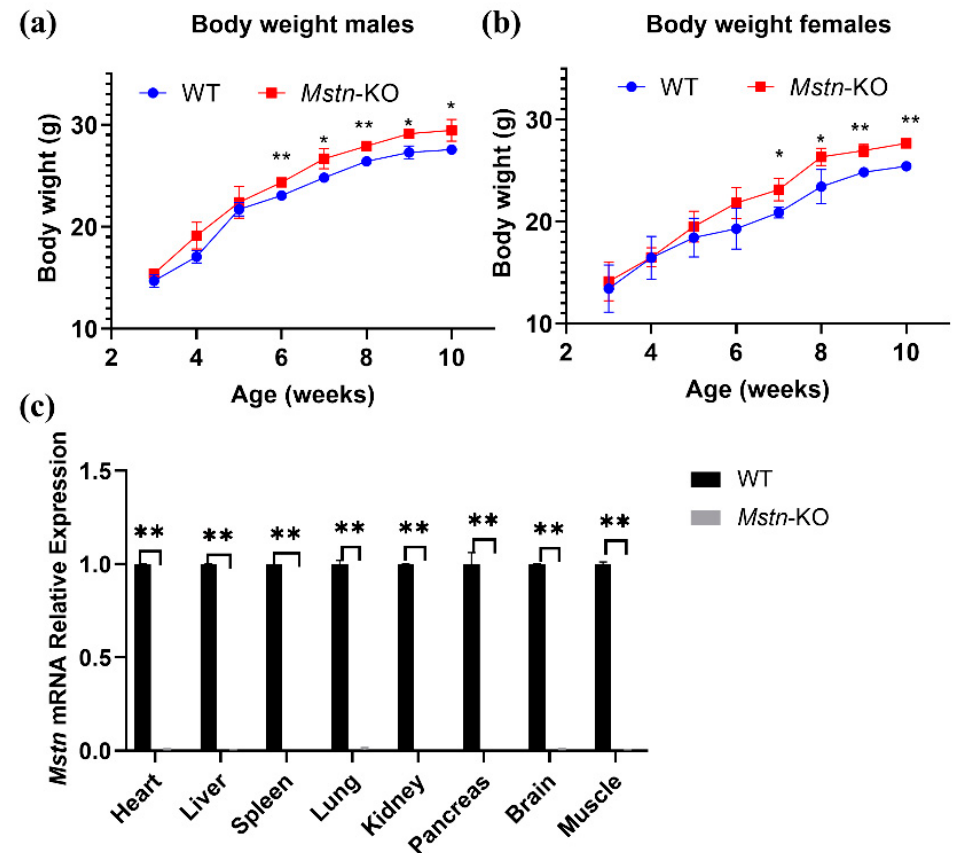
Figure 2. Comparison of growth performance between Mstn -KO and WT mice. ( a ) Comparison of body weights between Mstn -KO and WT male mice from 3 to 10 weeks. Body weight was slightly higher in Mstn -KO male mice than WT controls after 6 weeks ( n = 3). ( b ) Comparison of body weights between Mstn -KO and WT female mice from 3 to 10 weeks. Body weight was slightly higher in Mstn -KO female mice than WT controls after 7 weeks ( n = 3). ( c ) Mstn mRNA expression in organs of Mstn -KO and WT mice ( n = 3). All data are presented as mean ± SD. * p < 0.05, ** p < 0.01; t-tests were used to calculate the p-values. Table 1. Organ weight of Mstn -KO and WT mice.